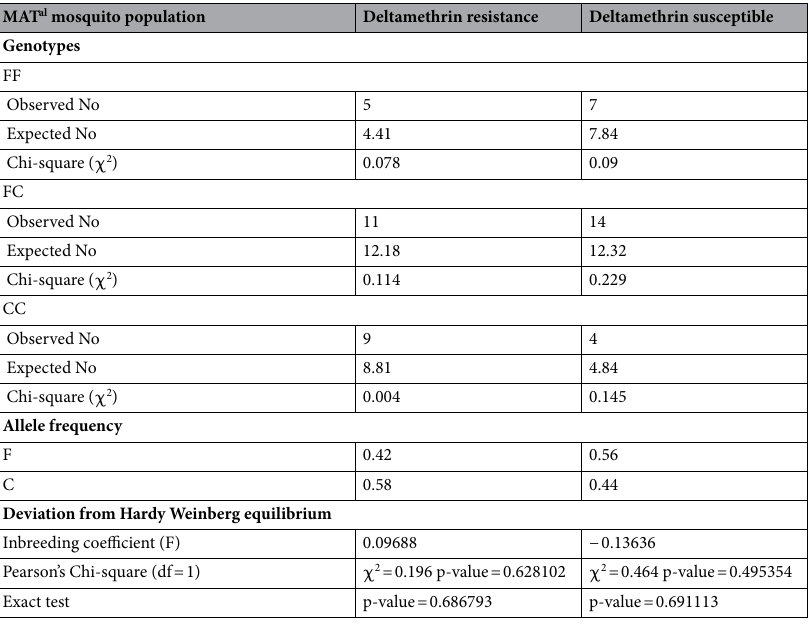
Table 2. Distribution of knockdown resistance genotypes in relation to Hardy–Weinberg proportion for deltamethrin resistance and deltamethrin susceptible Ae. albopictus from northern part of West Bengal, India.